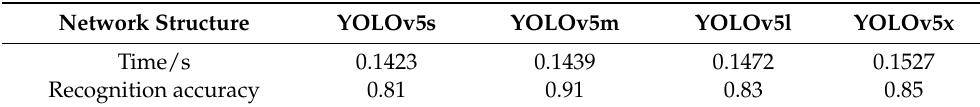
Table 4. Test results for different YOLOv5 models.